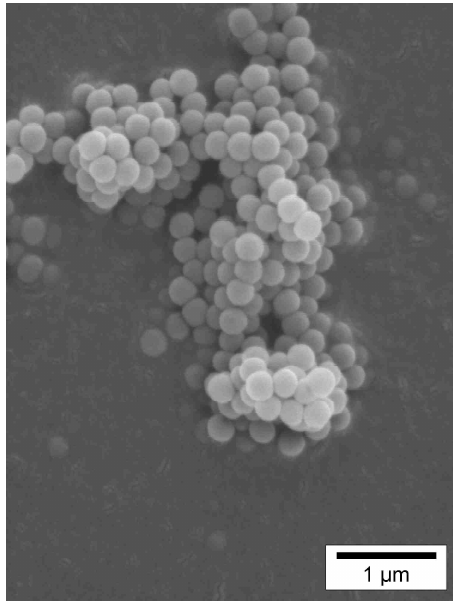
Figure 3. Electronic microscopy of formulation F-5.